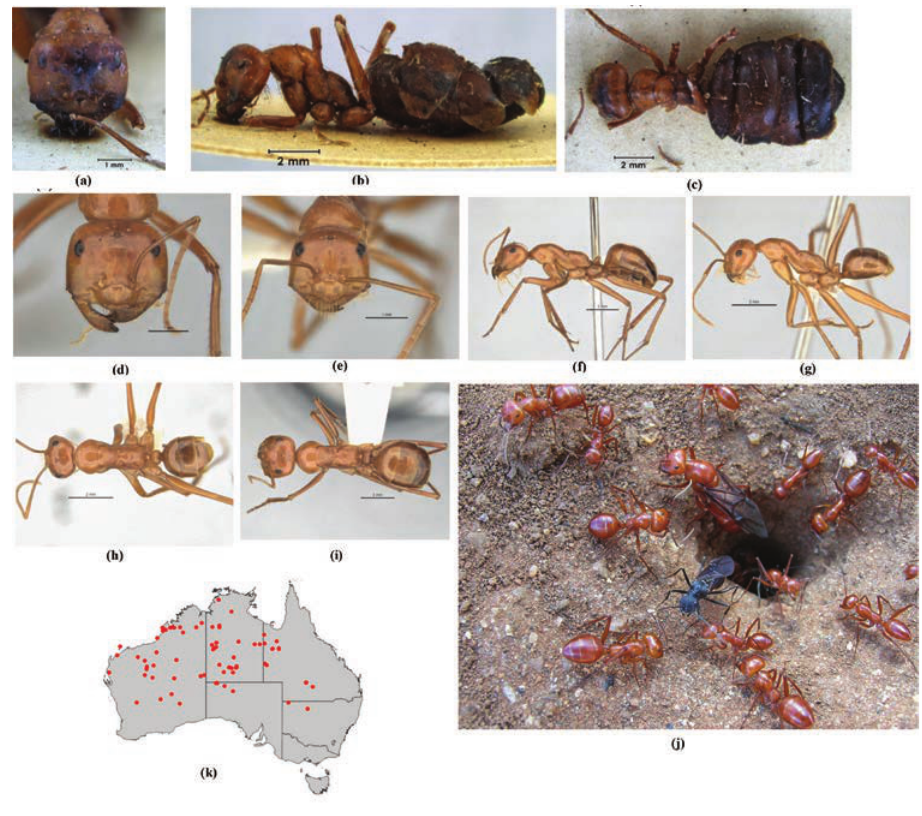
Figure 23. Melophorus bagoti Lubbock: BMNH major worker syntype (CASENT0903260) frons ( a ), profile ( b ) and dorsum ( c ); non–type major worker (ANIC3-900190–top ant) frons ( d ), profile ( f ) and dorsum ( i ); non–type minor worker (ANIC3-900190–bottom ant) frons ( e ), profile ( g ) and dorsum ( h ); Melophorus bagoti workers and reproductives at nest entrance (photo credit: A. J. Narendra) ( j ); distribu- tion map for the species ( k ). Low resolution scale bars: 2 mm ( f, g, h, i ); 0.5 mm ( d, g